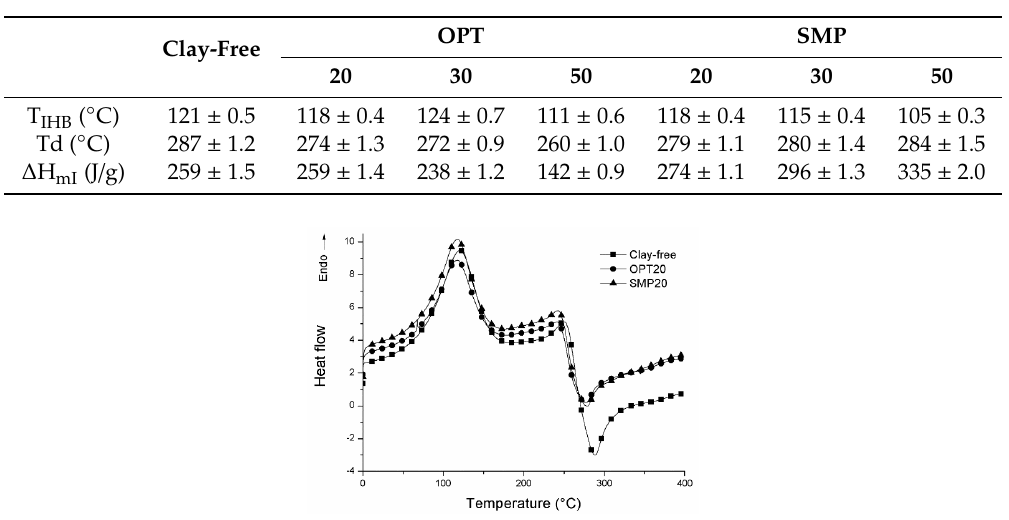
Figure 2. Differential scanning calorimetry (DSC) thermograms of Clay-free, OPT20 and SMP20 Figure2. Di ff erentialscanningcalorimetry(DSC)thermogramsofClay-free, samples.